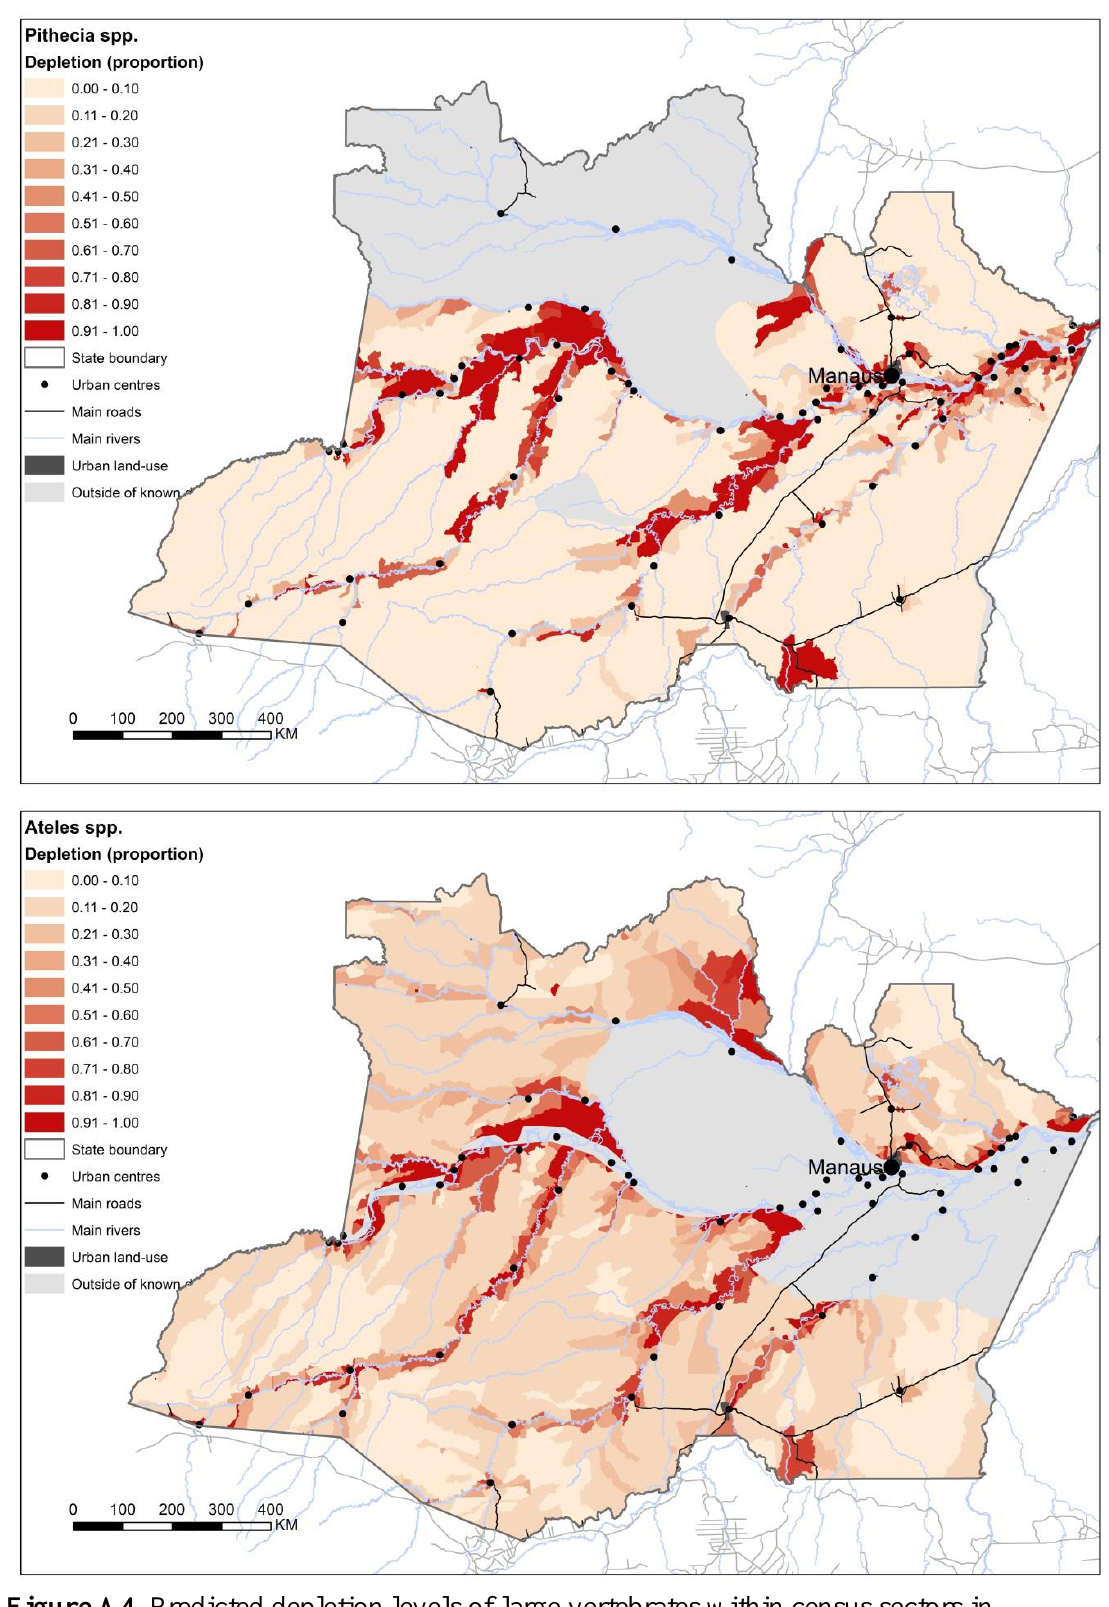
Figure A4. Predicted depletion levels of large vertebrates within census sectors in Amazonas State, Brazil, based on species-specific predictive models that used human population density, coverage of terra firme upland, and travel distance to the nearest urban